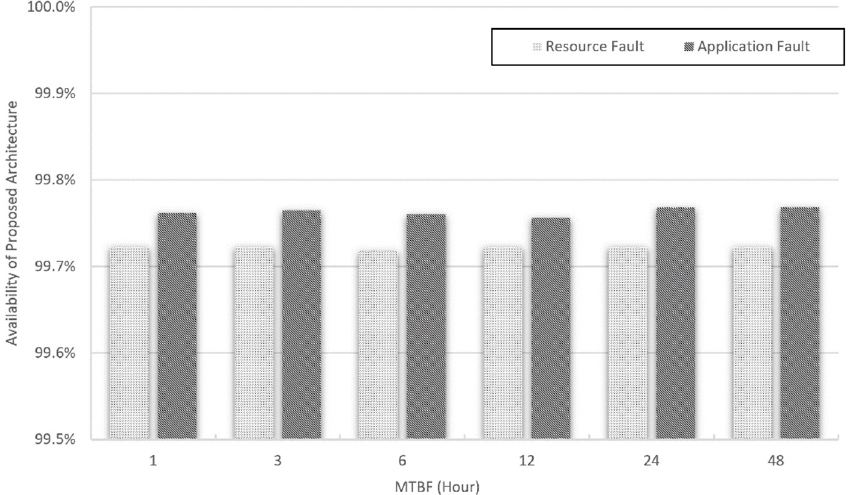
Figure 17. Availability of proposed architecture.